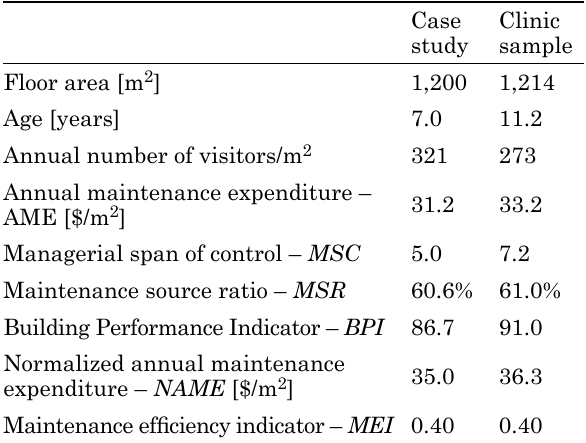
Table 3. Comparison of the characteristics of the whole clinic sample with those of the case